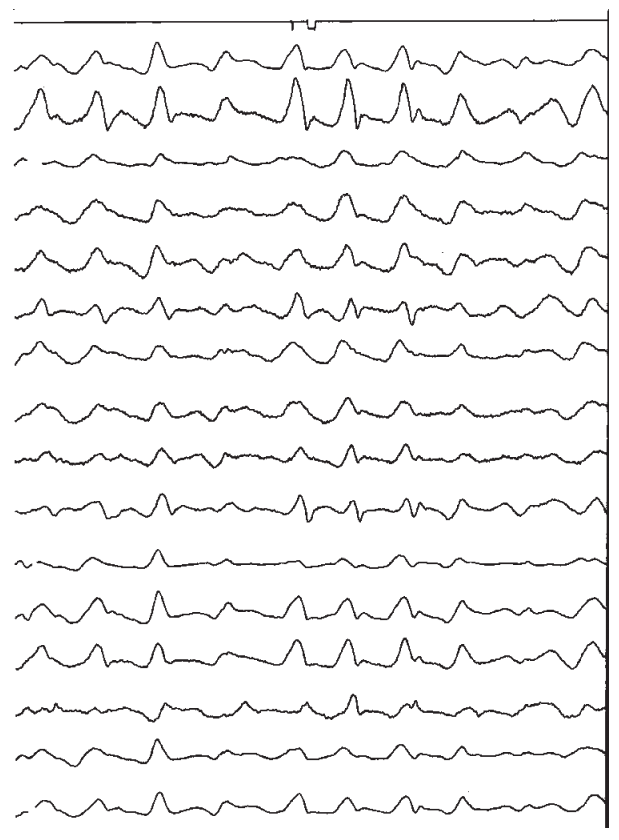
Figure 1 - Electroencephalogram pattern showing diffuse cerebral involvement, with slow waves being predominantly delta waves, frequently in a triphasic pattern, mainly at front and